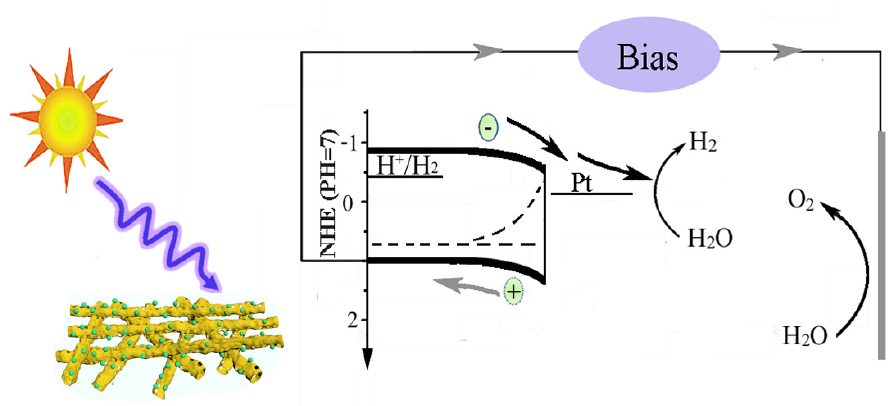
Figure 7. The transport process of electron–hole pairs.